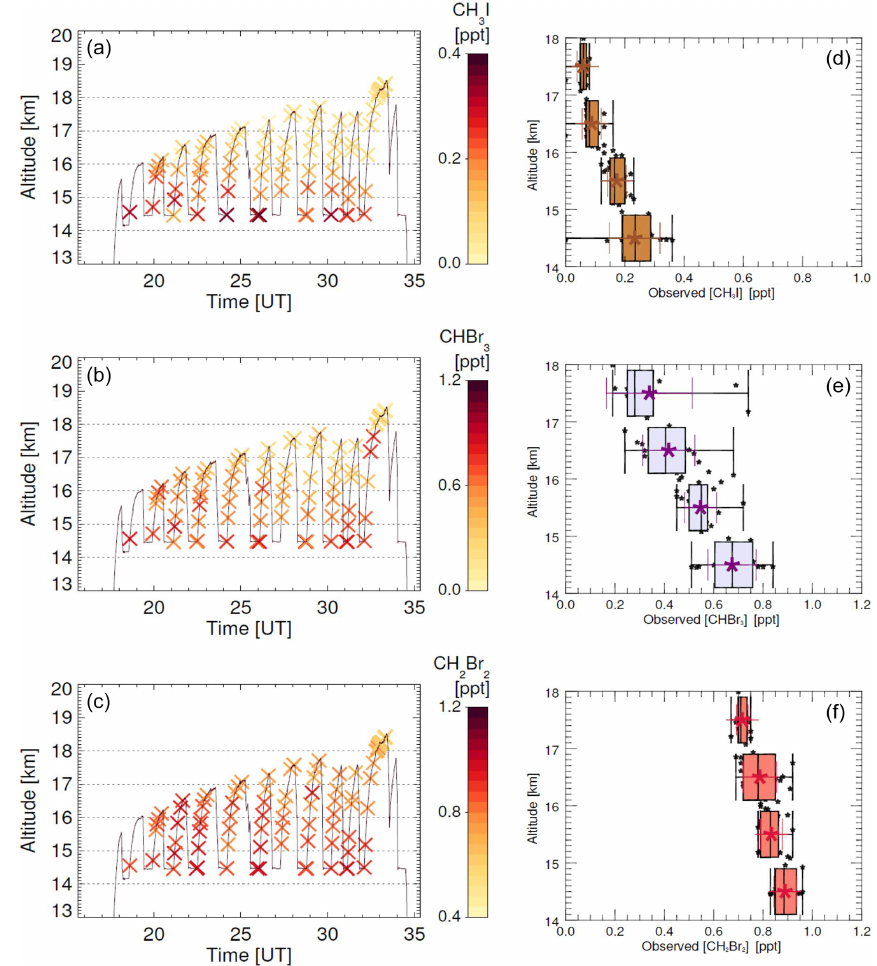
Figure 1. Vertical distribution of CH 3 I, CHBr 3 and CH 2 Br 2 in the TTL, as measured during research flight 02, ATTREX 2014. AWAS measurements along the flight track (a–b) and observations grouped into 1km TTL segments (d–f) : mean (star symbols), standard deviation (coloured whiskers), minimum, lower and upper quartiles, median, and maximum (black box and whiskers).